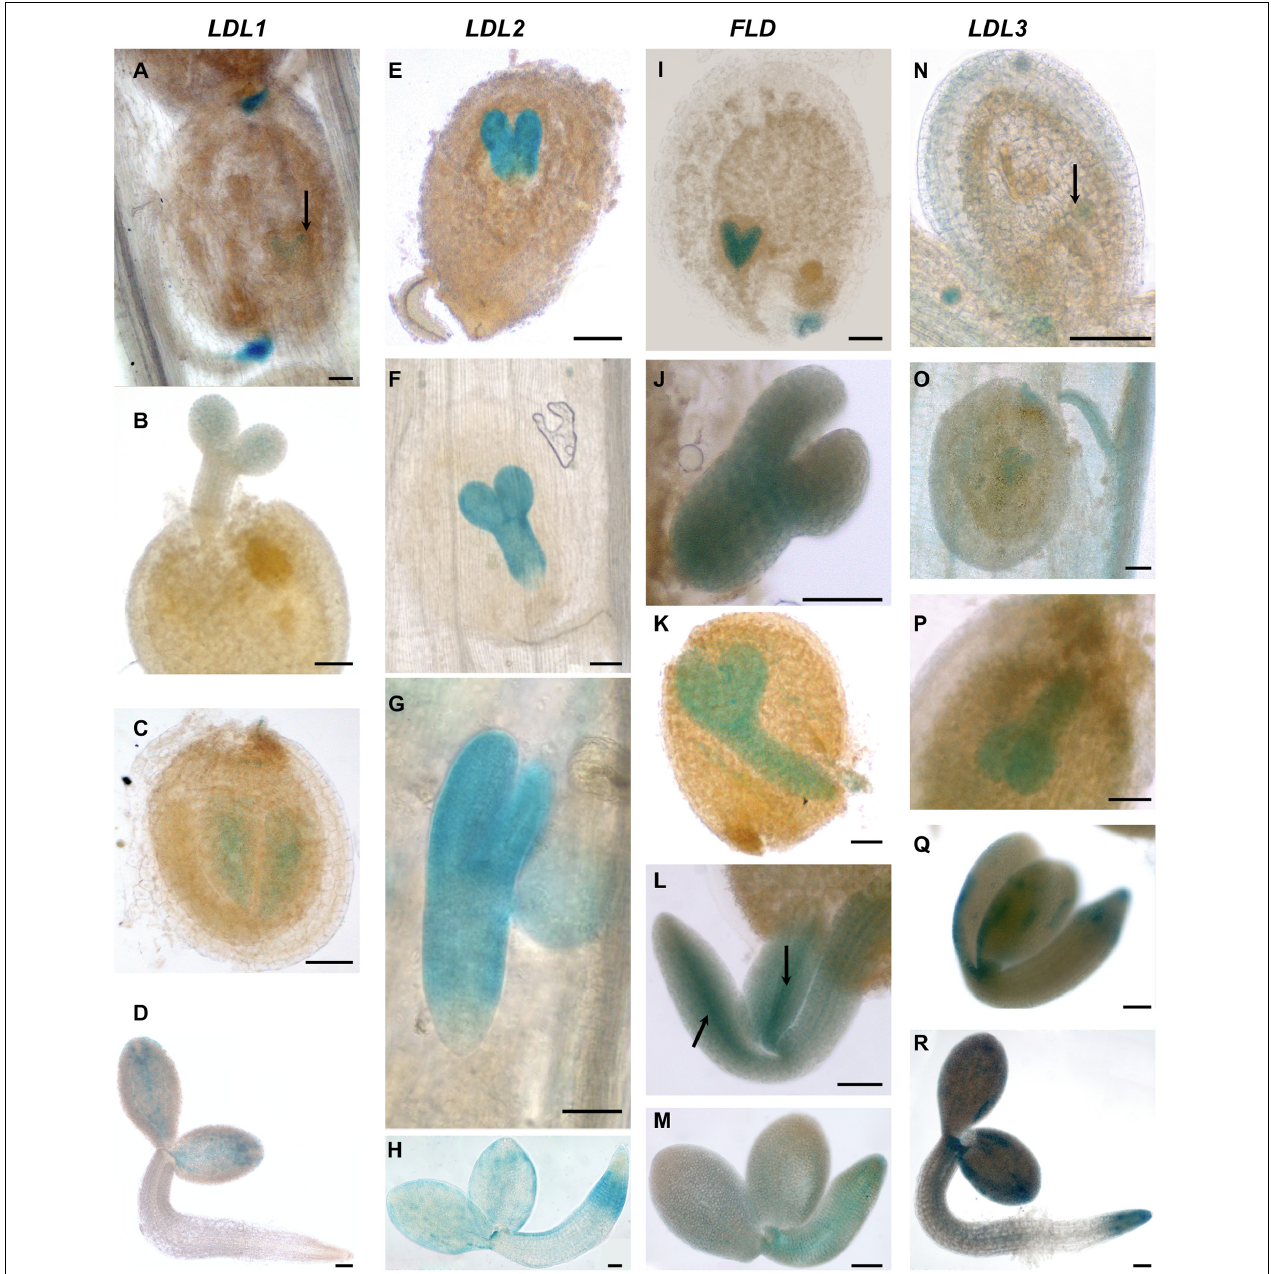
FIGURE 6 | Promoter activity of Arabidopsis LDL/FLD genes during embryogenesis and in imbibed seeds. Histochemical GUS staining of LDL/FLD::GFP-GUS transgenic plants in siliques (A–C,E–G,I–L,N–Q) and imbibed seeds (D,H,M,R) . Black arrows indicate LDL1 -specific staining in embryo (A) , FLD -specific staining in provascular tissues of roots and cotyledons in embryo (L) and LDL3 -specific staining in globular stage of embryo (N) . Bars indicate 50 µ